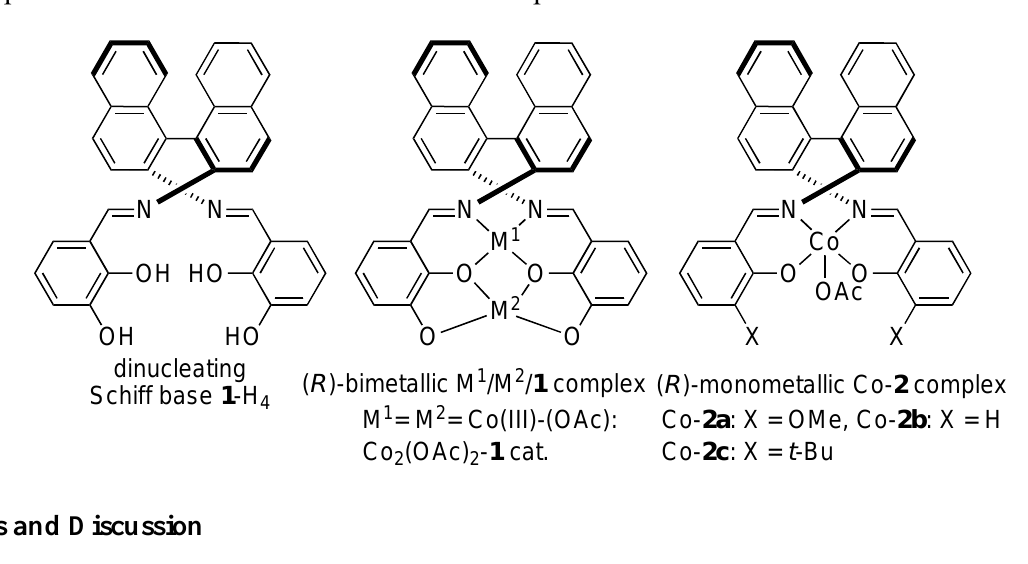
Figure 1. Structures of dinucleating Schiff base 1 -H